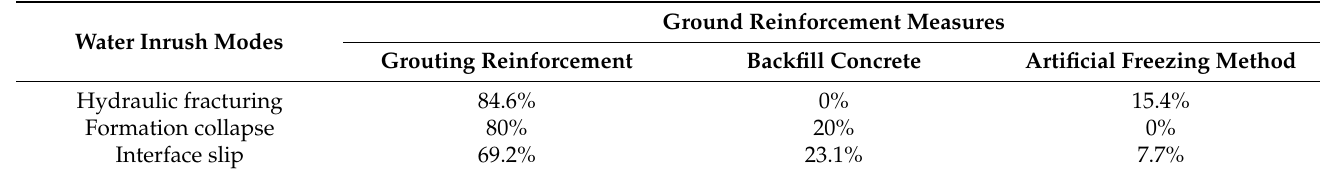
Table 7. Percentage of reinforcement measures corresponding to different water inrush